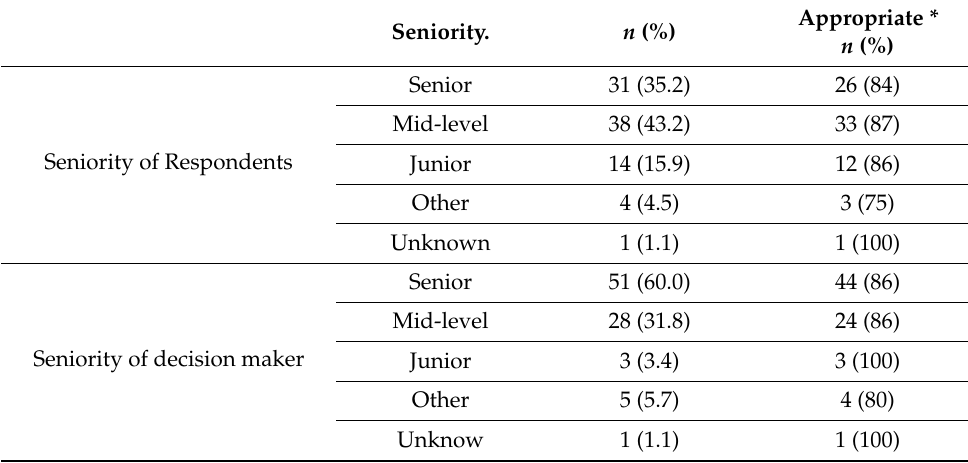
Table 3. Appropriateness of Prescribing.